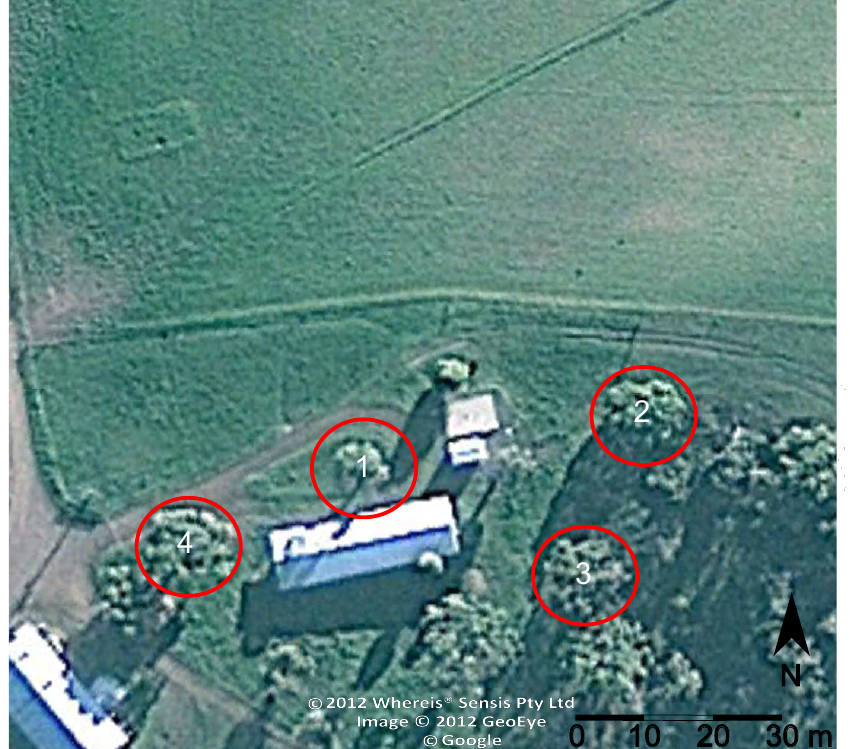
Figure 4. Locations of the individual trees manually delineated from the point cloud for use in determining the repeatability of individual tree metric measurements using the UAV-borne LiDAR